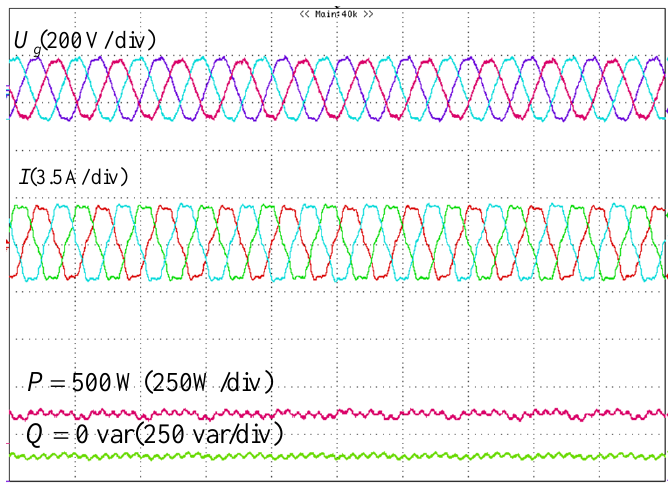
Figure 12. Operation of VSC under a inter- harmonics grid without the proposed control.